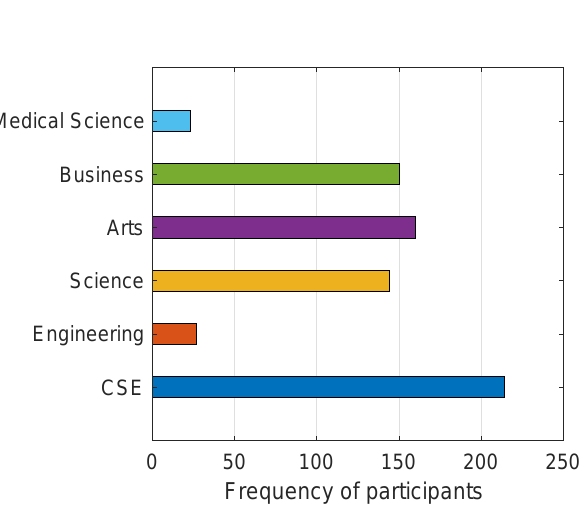
Table 1. Total number of people who participated in the survey. The sample is biased towards students